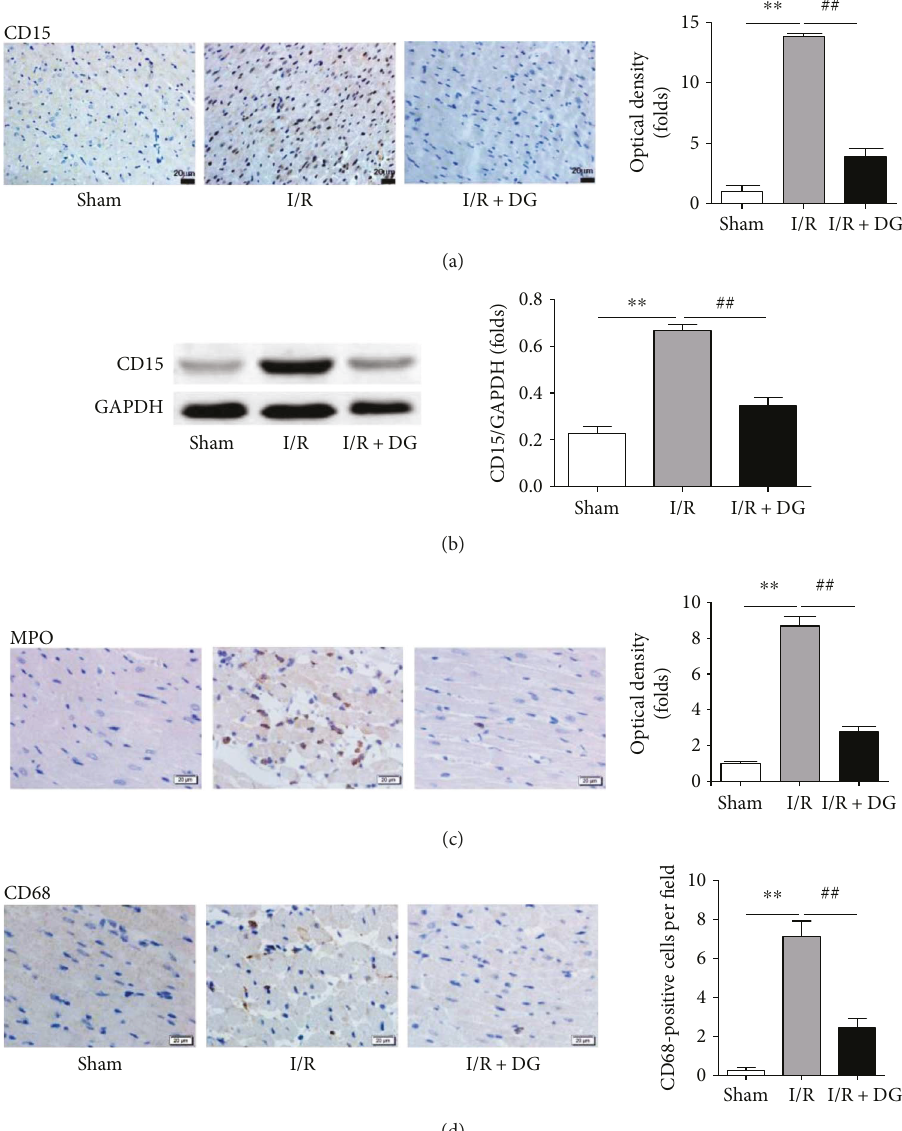
Figure 4: Dunye Guanxinning inhibited myocardial neutrophil in fi ltration. (a) Immunochemical staining and optical density of anti-CD15 antibody (each n = 3 ); (b) CD15 immunoblot of the left ventricular tissue (each n = 4 ); (c) immunochemical staining and optical density of anti-MPO antibody ( n = 3 ); (d) immunochemical staining and the number of anti-CD68-positive cells ( n = 3 ). Data are expressed as mean ± SD. ∗∗ P < 0 01 versus sham operation group; ## P < 0 01 versus ischemia-reperfusion